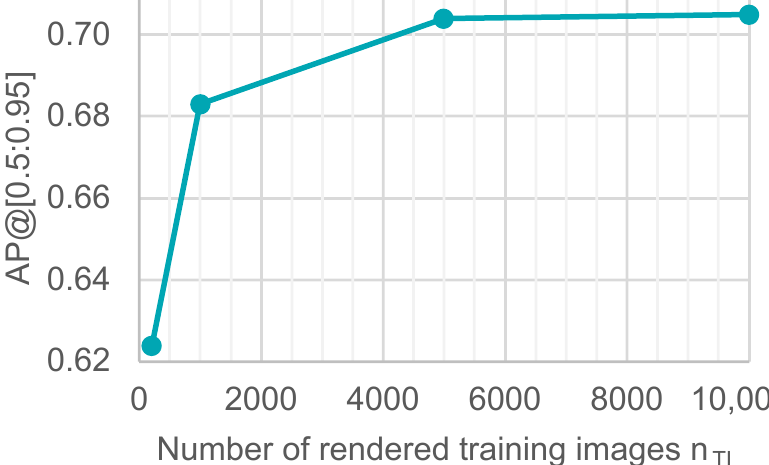
Figure 12. The impact of adding more synthetic training images on the object detection model for a training time of up to 24